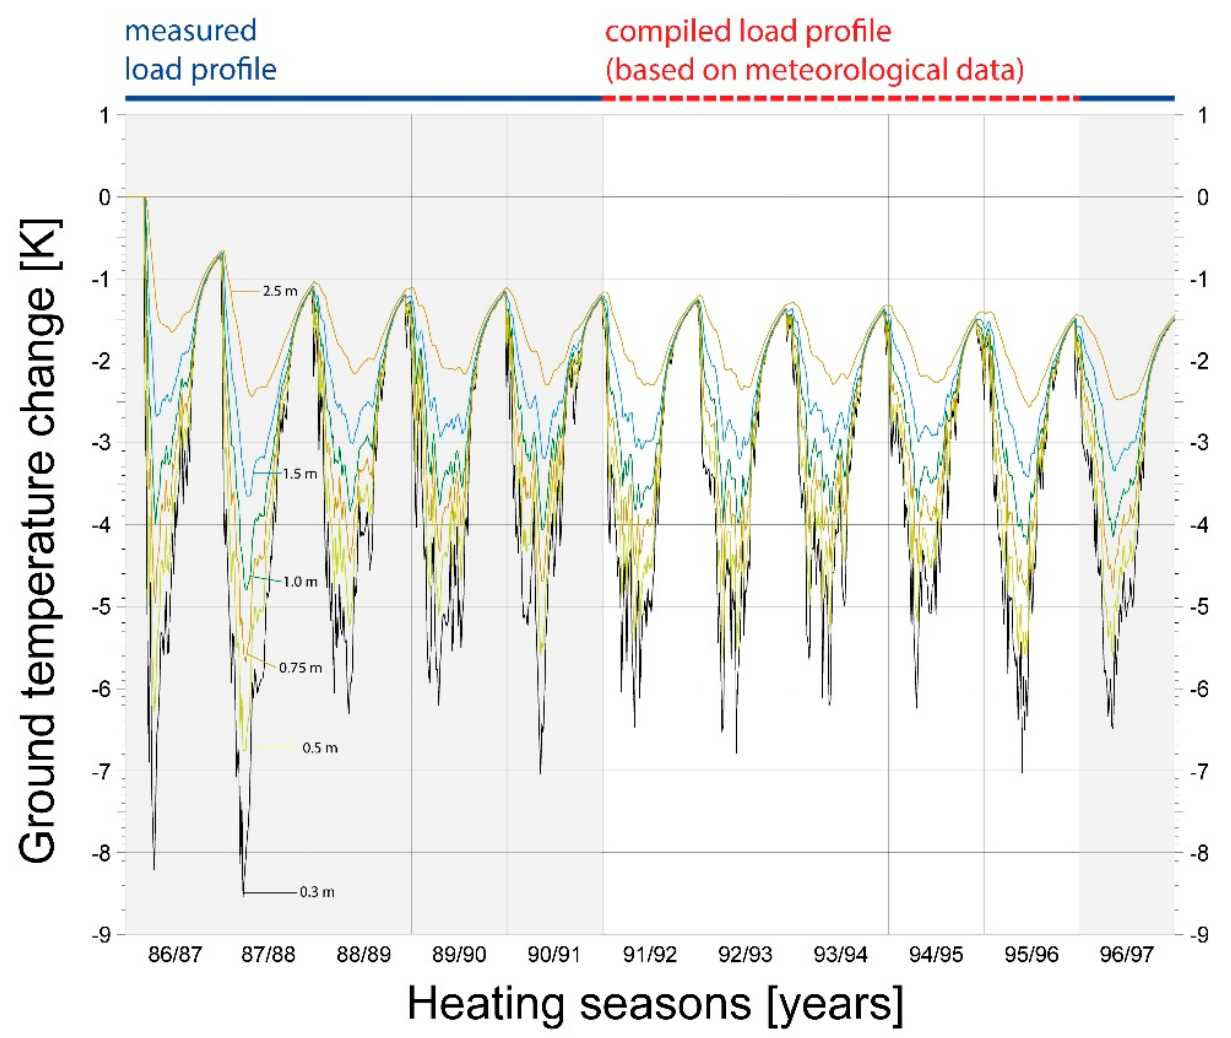
Figure 8. Cooling and recovery of the ground in 50 m depth, at different distances from the BHE. Shows measured data during the first six heating seasons (1986/87–1991/92), the rest (1992/93– 1995/96) were calculated by taking nearby meteorological data. The dynamics of the funnel-shaped temperature changes is eminent. Data from [5] are plotted.